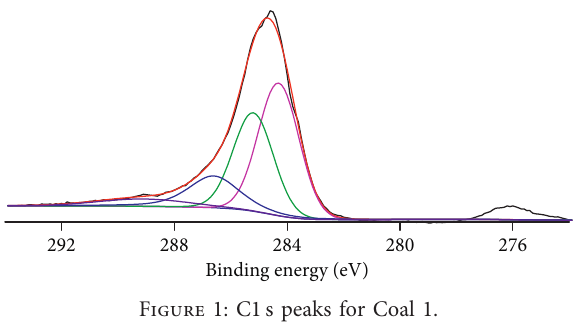
Figure 1: C1s peaks for Coal 1.